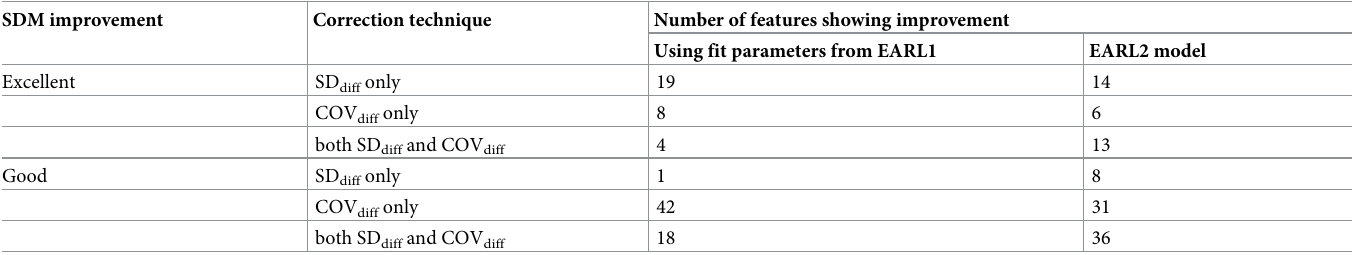
Table 2. Comparison of EARL2 results obtained by using the same fit parameters in EARL1 reconstruction with those by selecting the best fit for EARL2 recon- structed data using regression. SDM